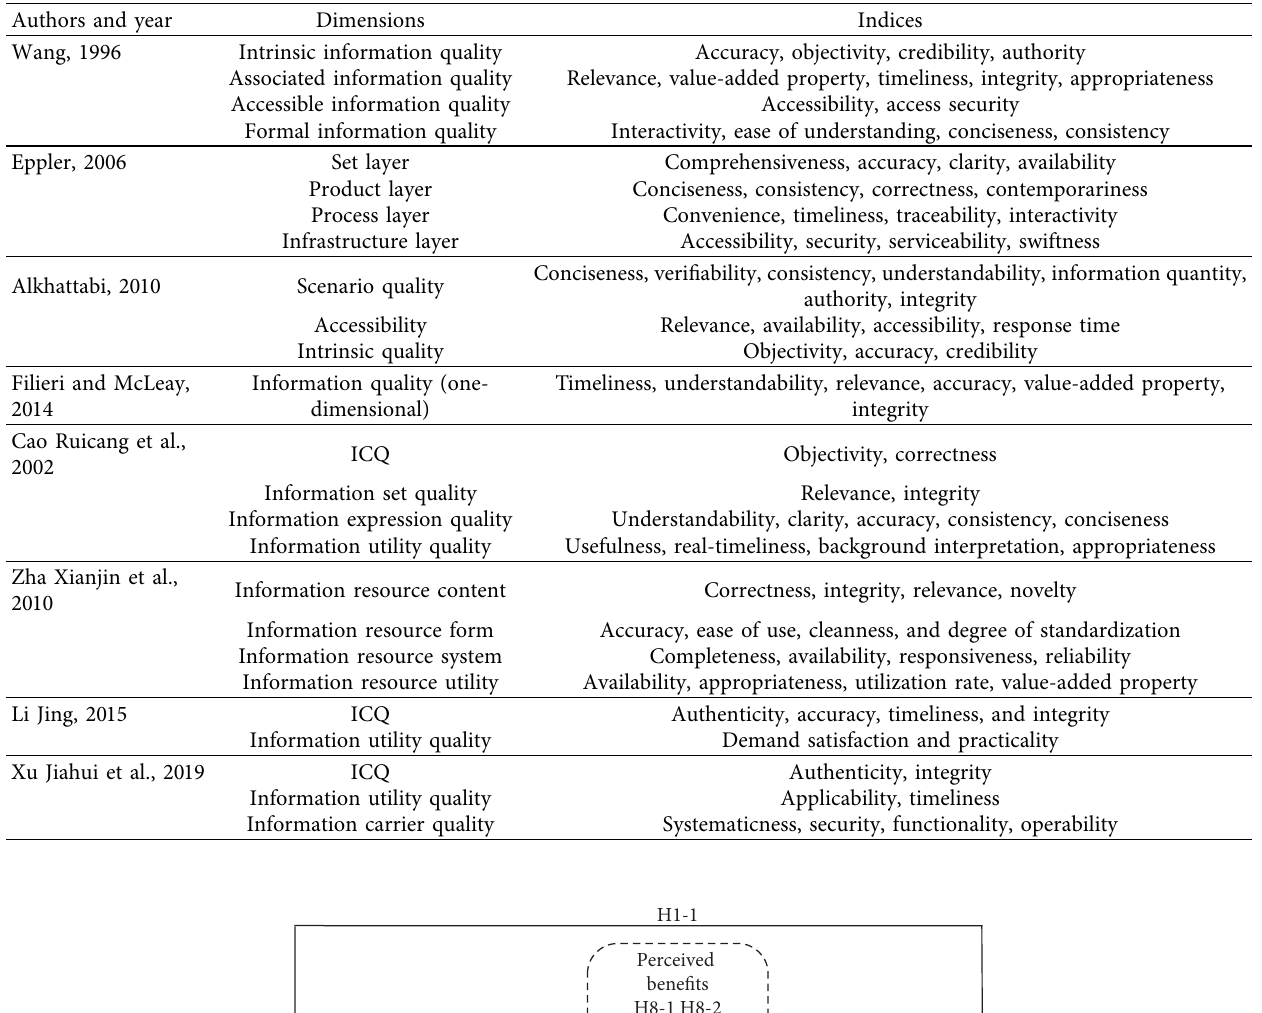
Table 1: Dimensions and indices of information